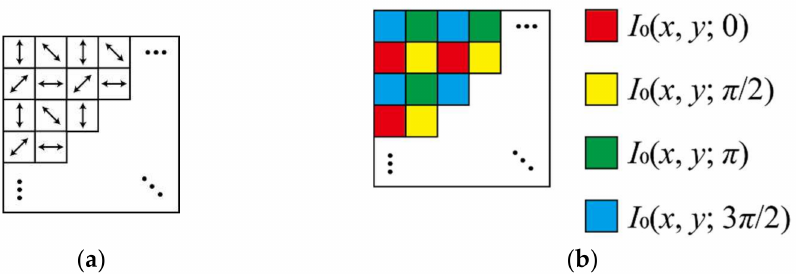
Figure 1. Parallel phase-shifting technique using the polarization image sensor: ( a ) polarizing axes of micro-polarizers attached to pixels and ( b ) phase shifts for